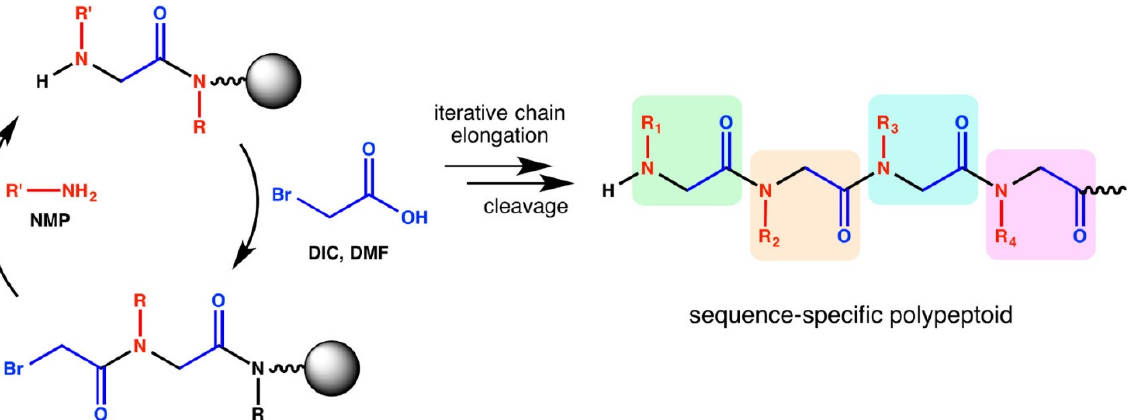
Figure 1. Solid-phase submonomer synthesis method allows the rapid synthesis of sequence-specific peptoids from cheap and readily available starting materials (Adapted from ref. [15]. Copyright 2013, American Chemical Society).